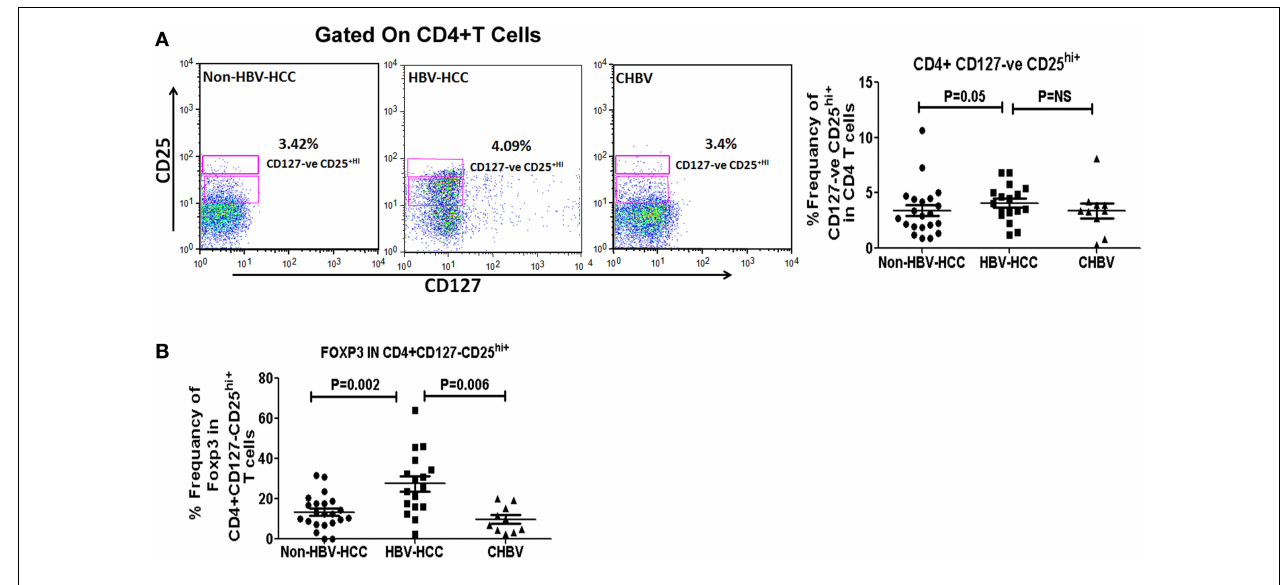
CD4 + CD25 + CD127 low Tregs in all three groups. (B) Scatter plot shows increased expression of FoXP3 positive